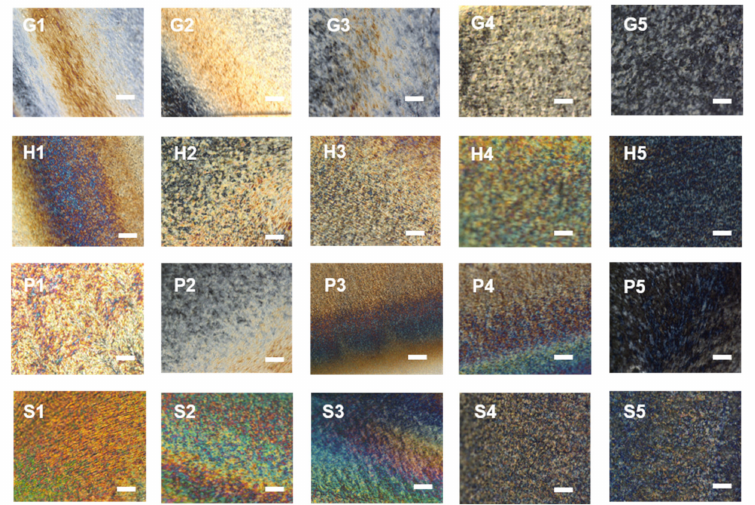
Figure 4. POM observations of the CNCs-based films incorporated with glycine, histidine, pheny- lalanine, and serine, with different AAs additions. Scale bar = 20 µ